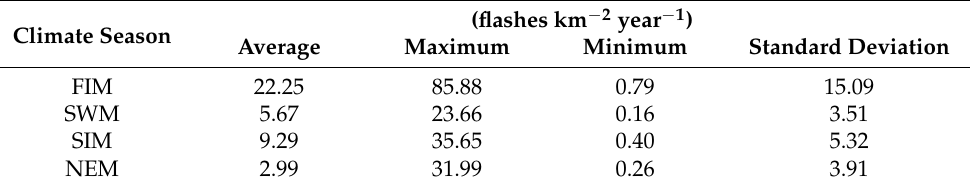
Table A5. Statistics of the seasonal variations of the lightning flash density, based on the 1998–2014 LIS Data from the TRMM Satellite.